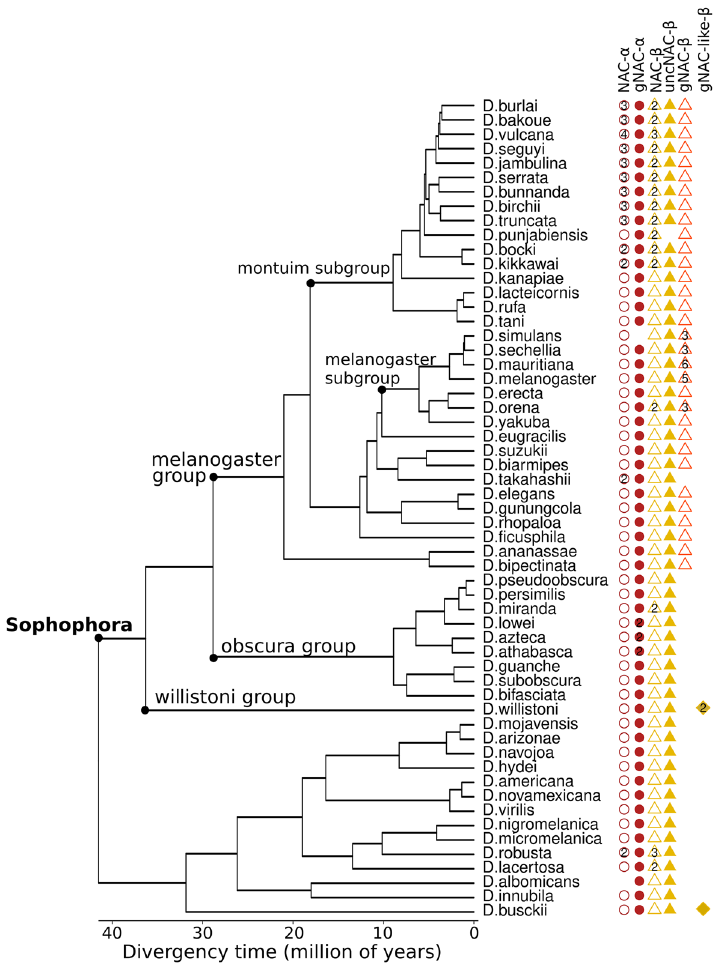
Figure 7. Phylogenetic tree of the Drosophila genus. The lack of some species ( mayri, watanabei, leontia, asahinai, pectinifera, obscura, montana, malanica and grimshawi ) on this tree is rather the result of the unfinished assembly of the corresponding genomes preventing the detection of the NAC domain sequences. The number of paralogs is shown within